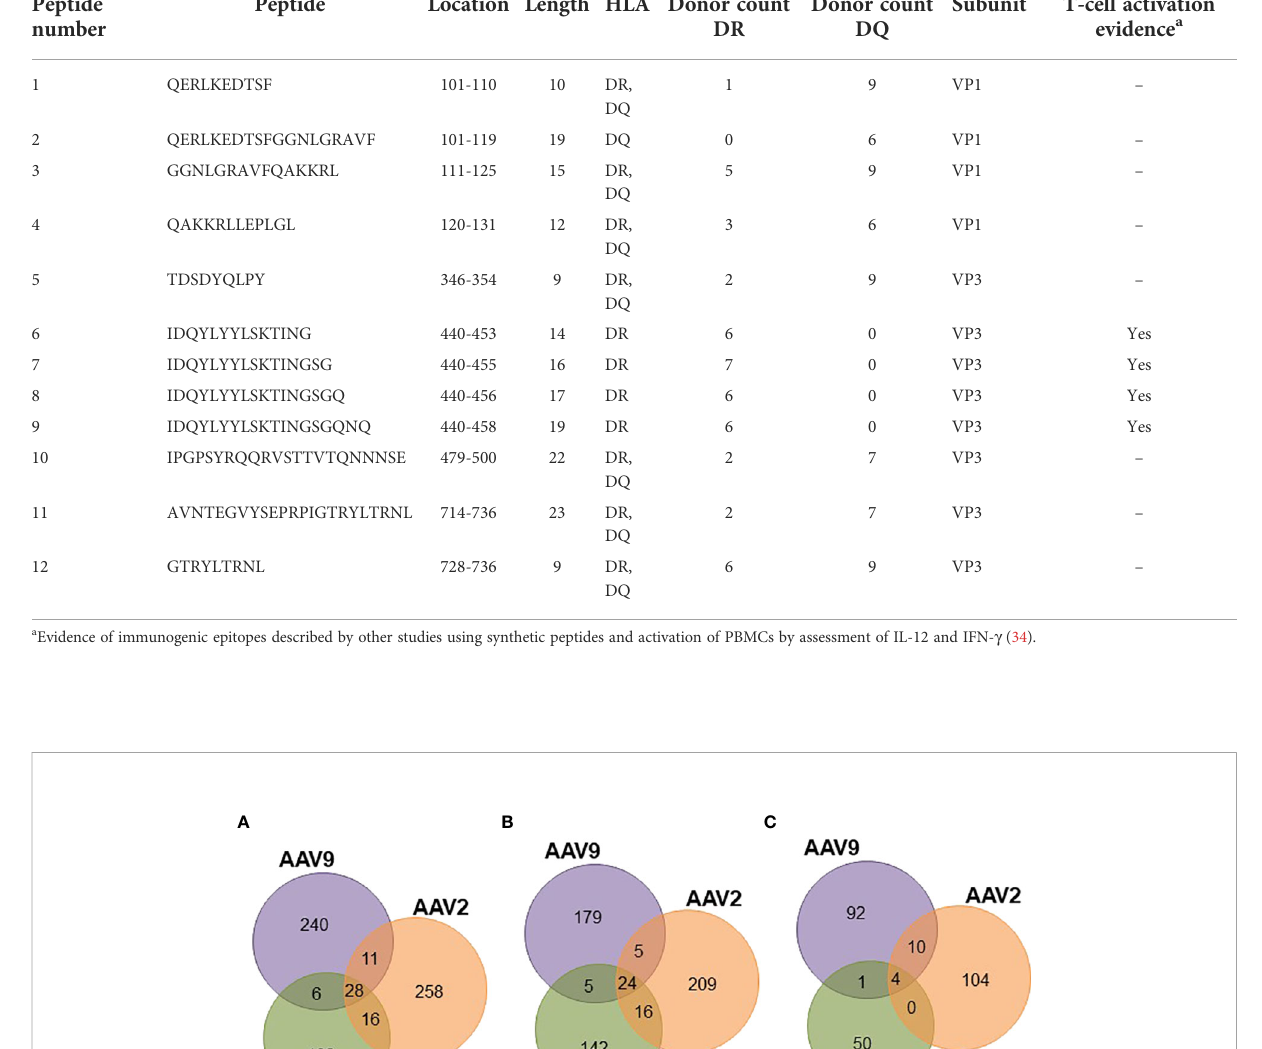
TABLE 4 Promiscuous peptides of AAV9 capsid.